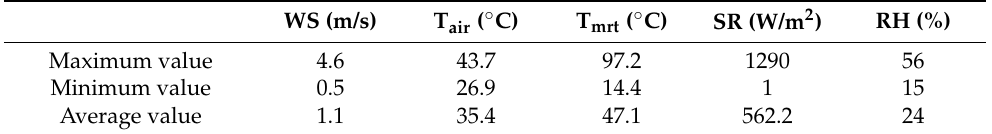
Table 6. Maximum, minimum, and average values of weather data from the portable weather meteorological